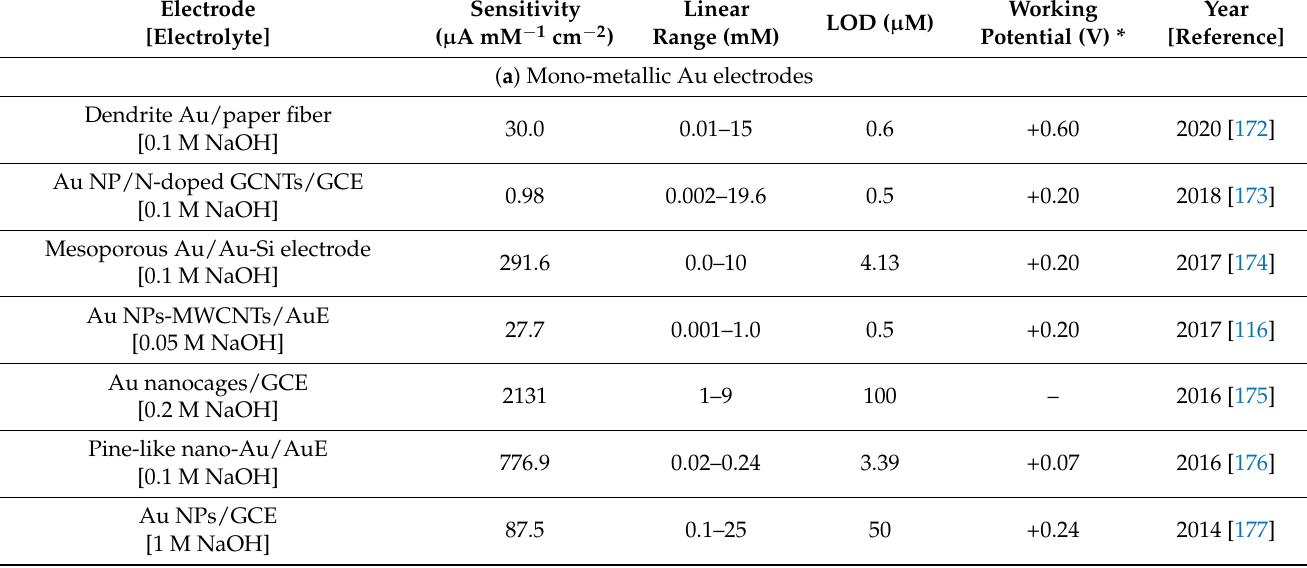
Table 2. Electrodes for the sensing of glucose by the noble mono-metallic ( a ) Au, ( b ) Pd, and ( c ) Pt materials within this decade. The performances are compared in terms of sensitivity, linear range, limit of detection (LOD), and working potential. The working potentials were based on the reference electrode of